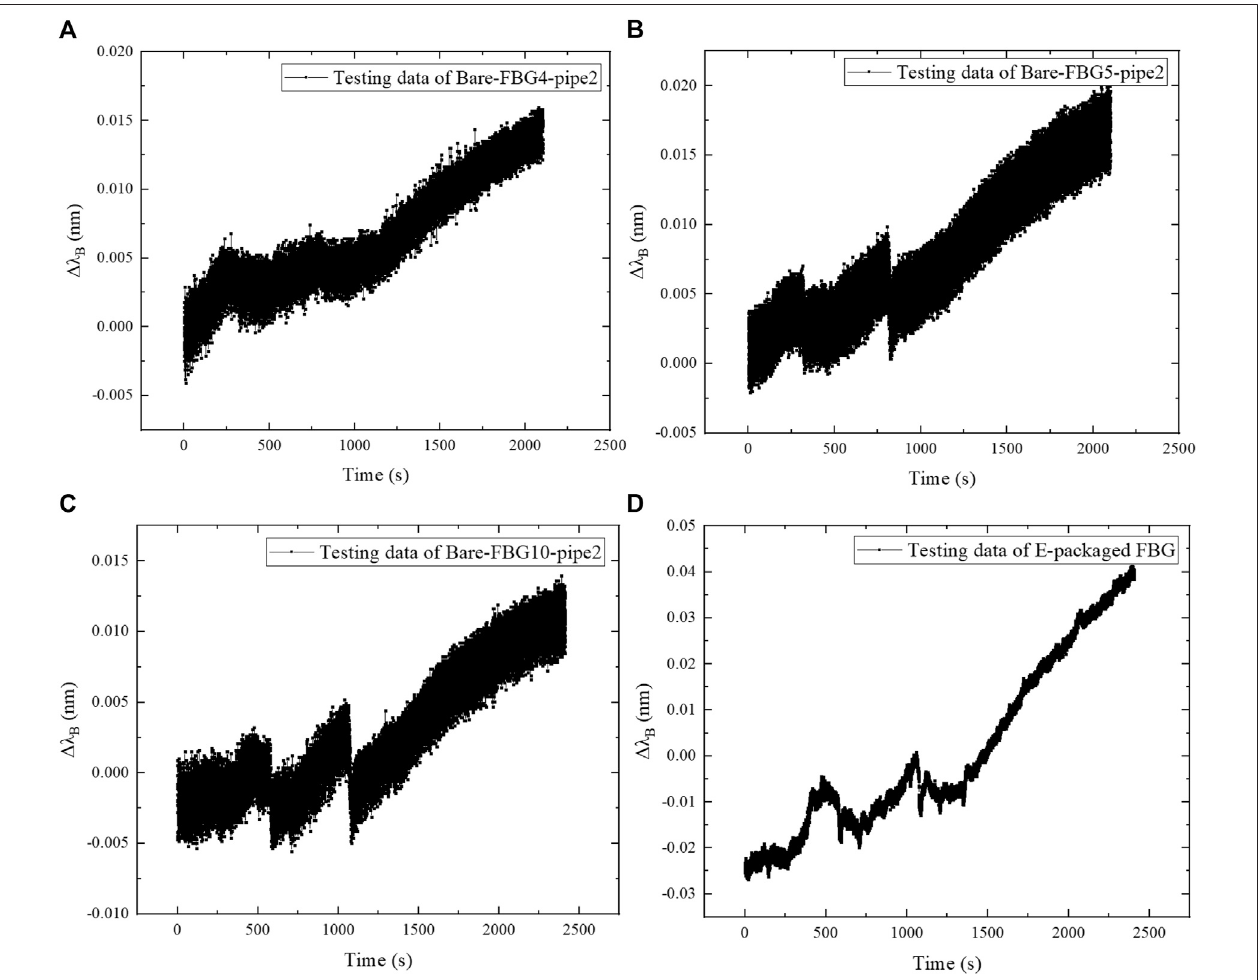
FIGURE 9 | Relationship of central wavelength increment with loading time at 50 Hz: (A) Bare-FBG4-pipe2; (B) Bare-FBG5-pipe2; (C) Bare-FBG10-pipe2; (D) E-packaged FBG.